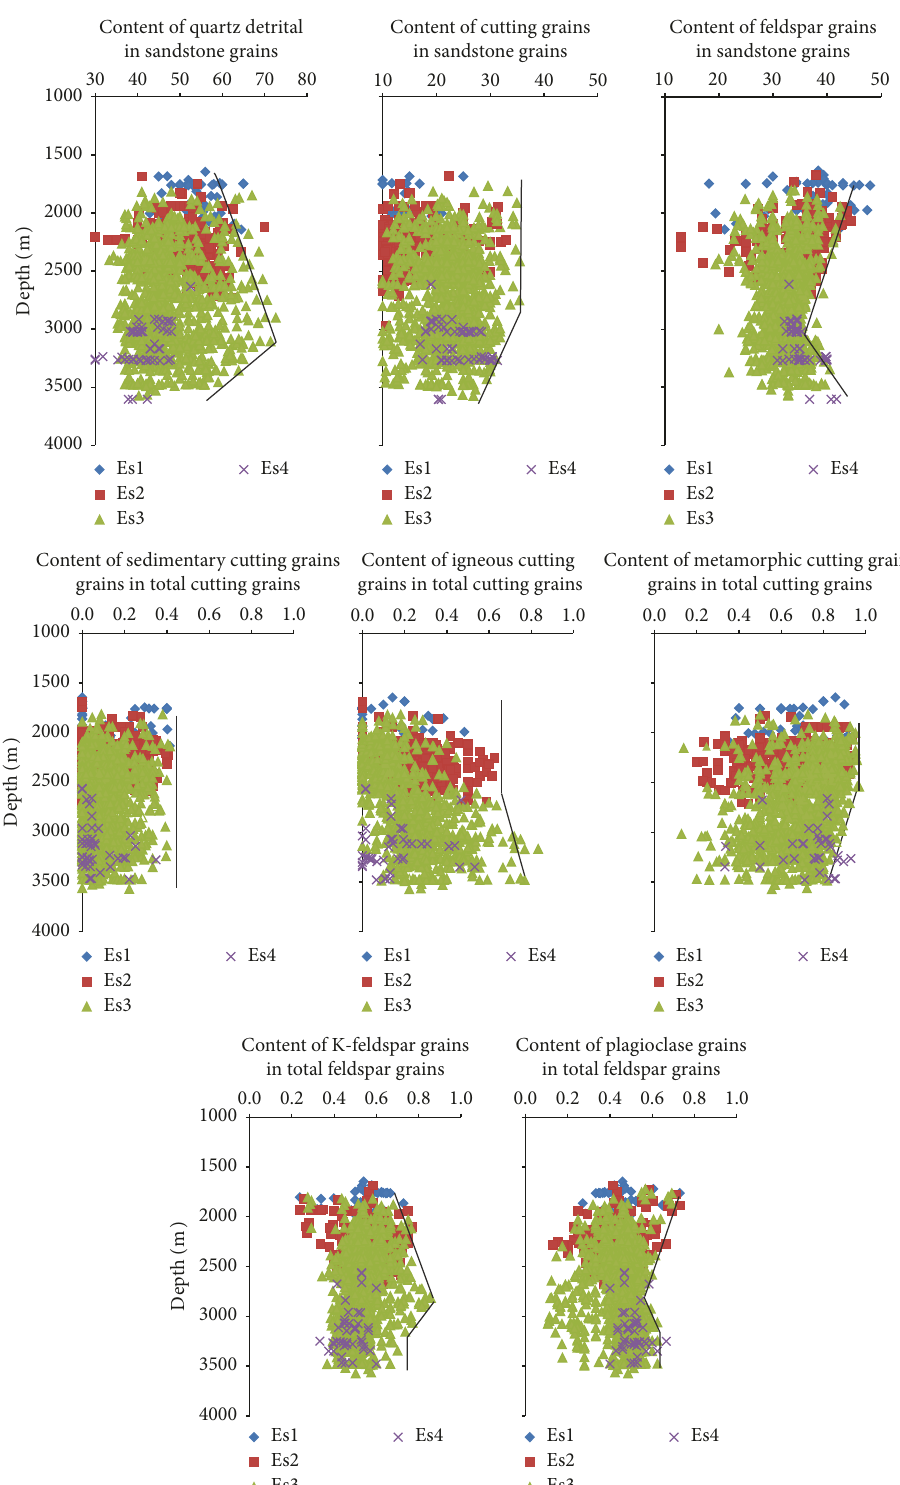
Figure 4: The content changes of different grains in sandstones of Es in Dongying